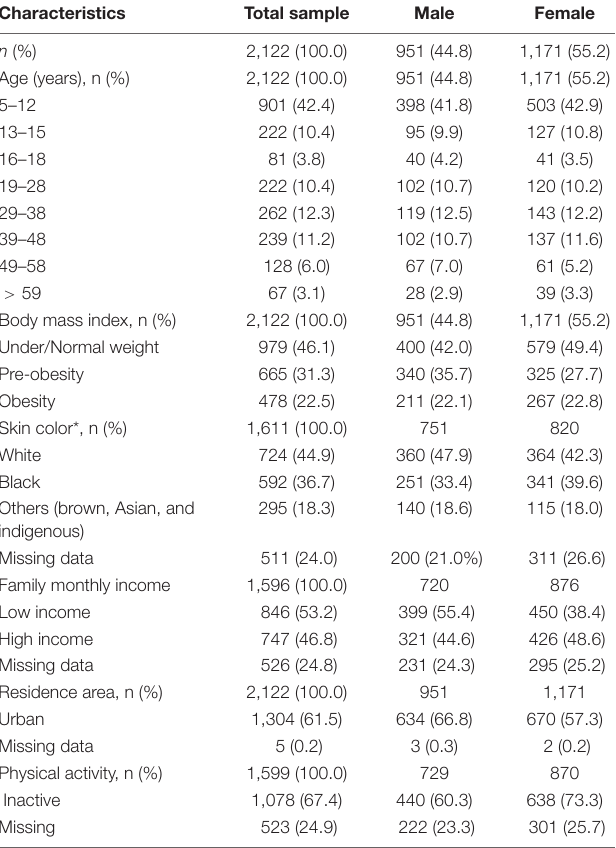
TABLE 1 | Characteristics of participants.